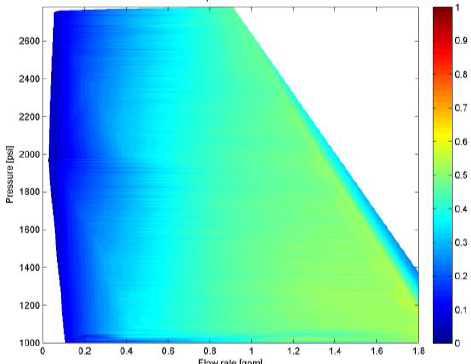
Figure 20. E ffi ciency of the electric system in the charging process using a piston pump Figure 20. Efficiency of the electric system in the charging process using a piston pump (estimated). Figure 20. Efficiency of the electric system in the charging process using a piston pump (estimated). Figure 20. Efficiency of the electric system in the charging process using a piston pump (estimated).